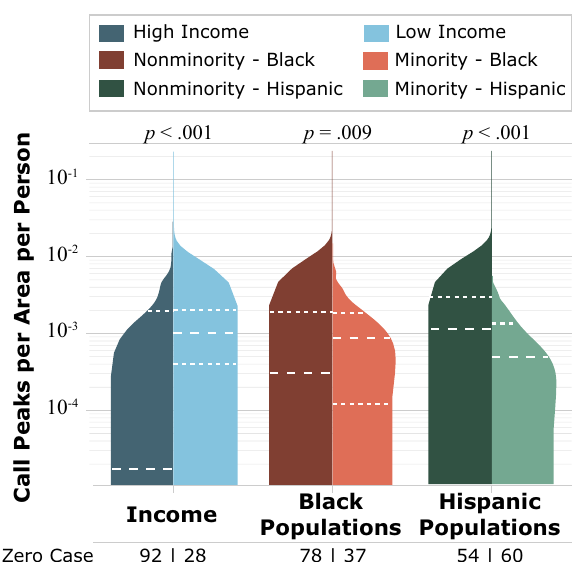
Fig. 7 Distribution of the 311 call peaks per area per person for income and race/ethnicity groups and numbers of unimpacted census tracts.